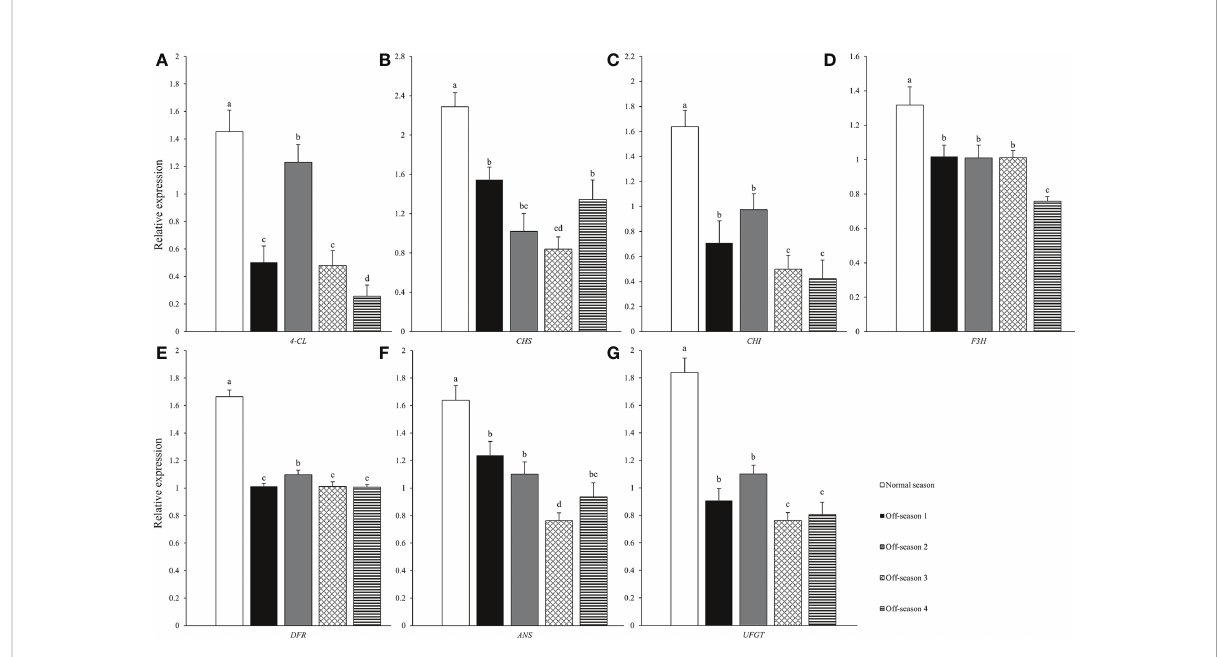
FIGURE 7 Anthocyanin synthesis structure genes between differential groups ’ mulberry fruits. (A) 4-CL , (B) CHS , (C) CHI , (D) F3H , (E) DFR , (F) ANS , (G) UFGT . Within a compound, bars labeled with different lowercase letters differ signi fi cantly ( P<